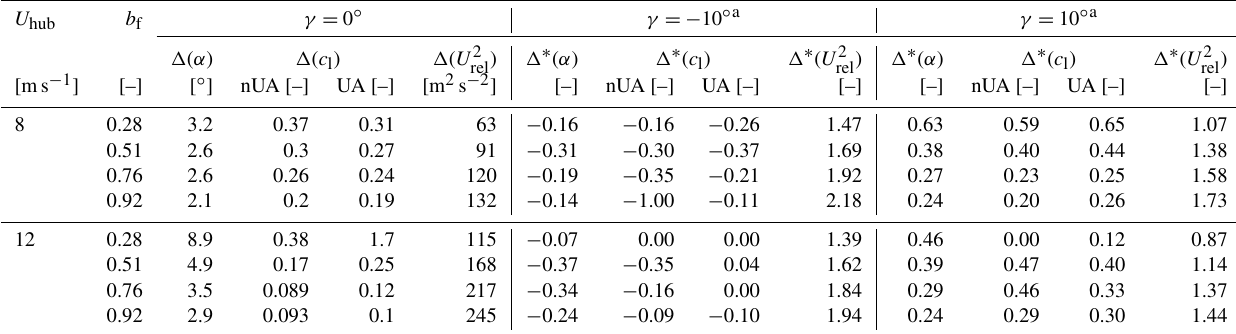
as calculated by AD15 (with induction) for various blade stations ( b f ) and hub-height wind speeds Table 3. Ranges ( (cid:49) ) for α , c l , and U 2 rel ( U hub ) and for yaw offsets ( γ ) of 0, − 10, and 10 ◦ . A wind shear exponent of 0.2 was assumed. Results for (cid:49) ( c l ) are given with (UA) and without (nUA) unsteady aerodynamics effects included.